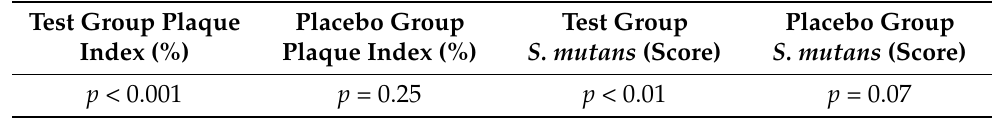
Table 4. Wilcoxon test p